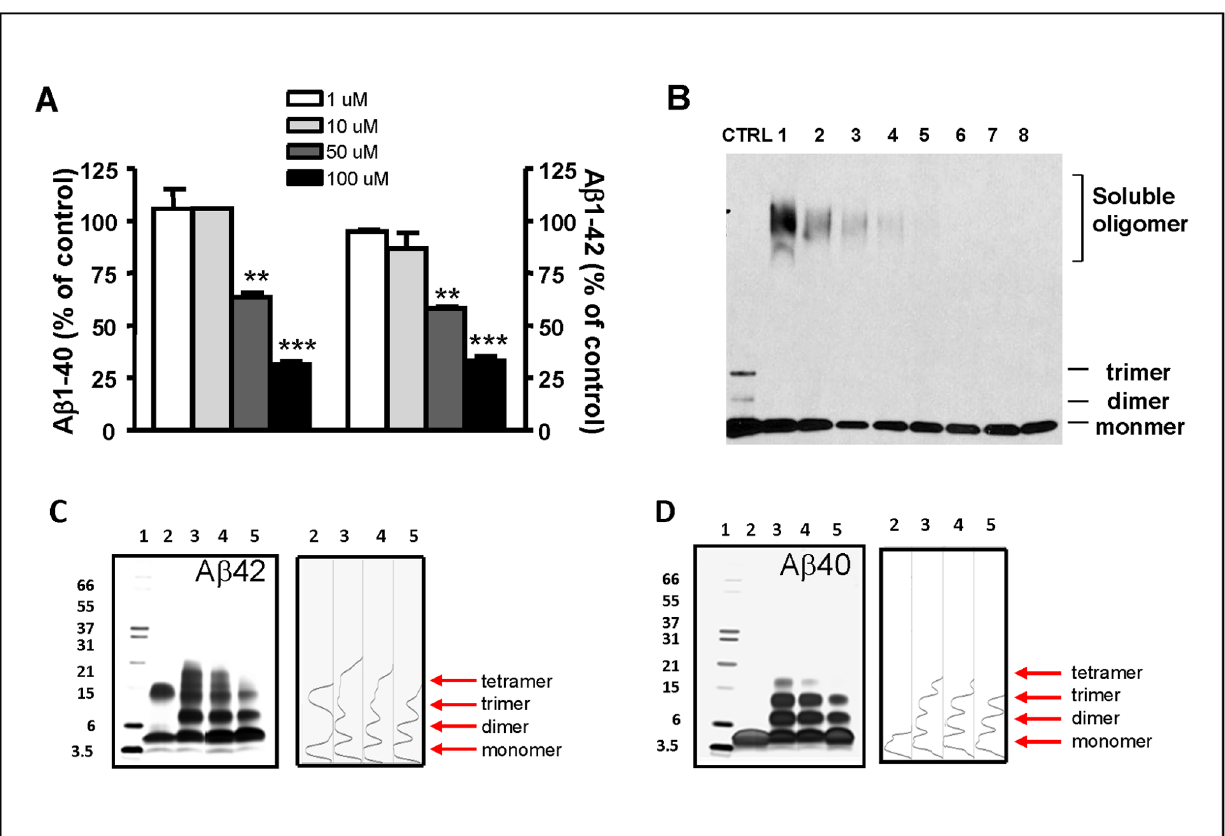
Figure 3. Representative invitro screening results for A b -lowering and anti-oligomerization activity. (A) Measurement of A b 1–42 and A b 1–40 in conditioned medium from Tg2576 primary neurons treated with different concentration of testing compound (B) Dose dependent inhibition of testing compound on synthetic A b 1–42 peptides aggregation into HMW oligomeric A b forms. A b 1–42 (final concentration 10 m M) was incubated with various concentrations of compound at 37 u C for 24 hours. Bands were visualized by western blot analysis probed with 6E10 antibody. MW: molecular weight, CTRL is A b 1–42 without incubation, Lane 1–8, 0, 10, 20, 40, 80,160, 320 and 640 m M of compound. (C and D) SDS-PAGE of A b 1– 42 (C) and A b 1–40 (D) in the presence or absence of testing compound following PICUP. A b 1–42 or A b 1–40 was cross-linked in the presence or absence of testing compound and the bands were visualized using silver staining. Lanes 1: molecular weight, lane 2: A b 1–42 or A b 1–40 peptides without PICUP reaction; lane 3: A b 1–42 or A b 1–40 peptides following PICUP reaction; Lanes 4 and 5: PICUP of A b peptides in the presence of an equimolar concentration (lane 4) or 10x molar excess (lane 5) of testing